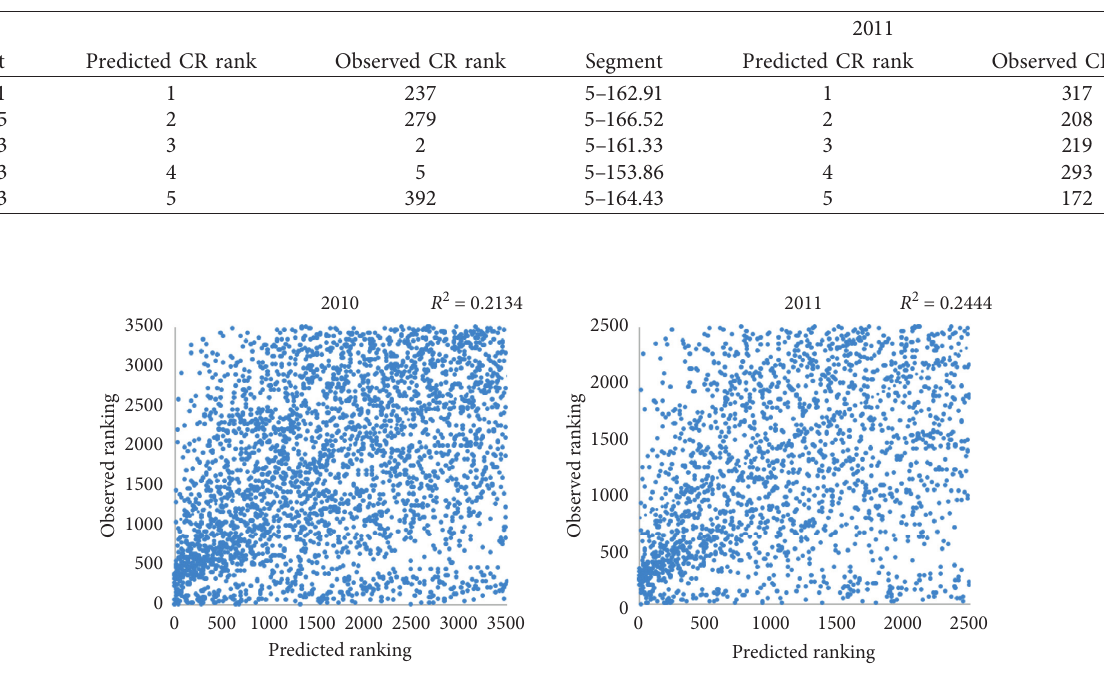
Figure 8: Correlation of predicted and observed CR